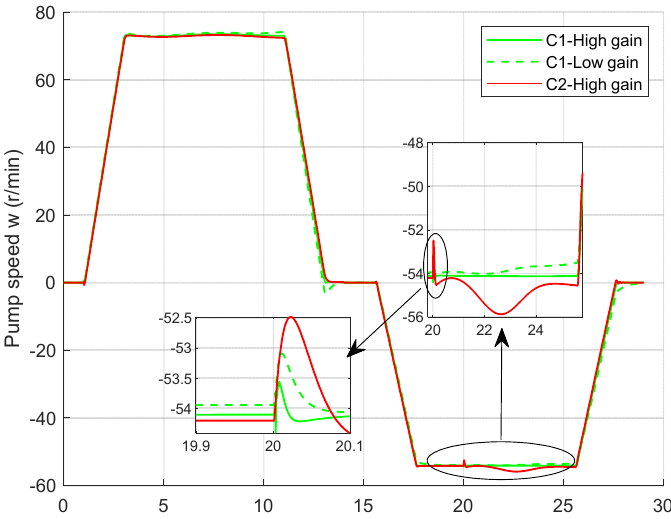
Figure 5. Pump speeds for C1 and C2 and response to the shock disturbance. ˆ e , ˆ e The errors 4 5